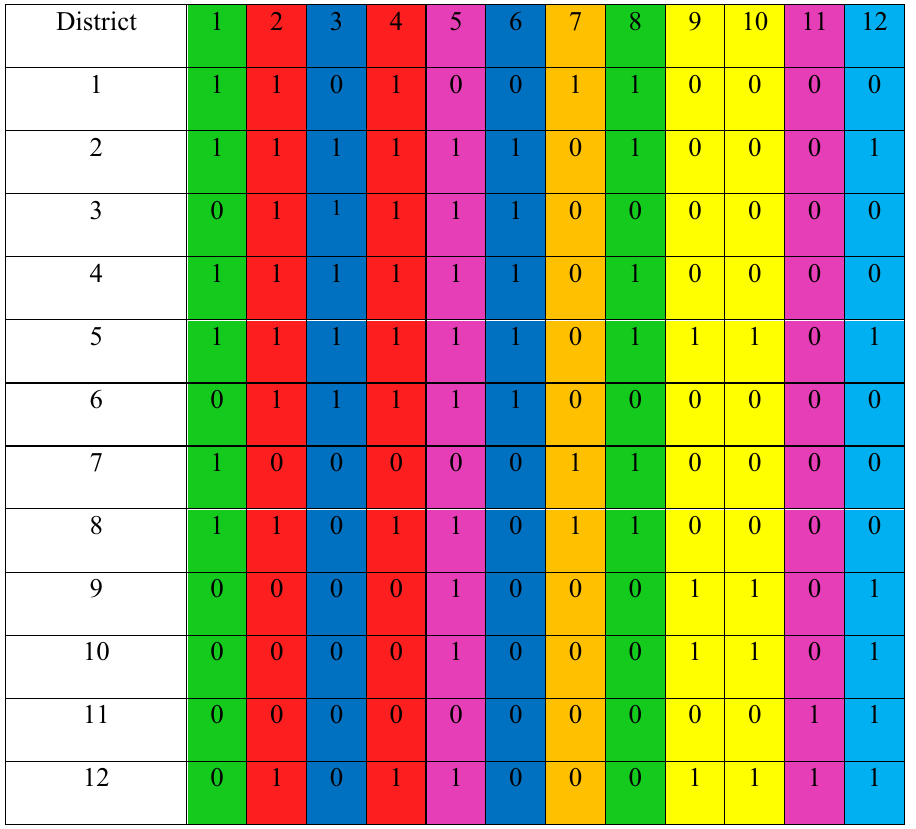
Table 8. Equivalence matrix and clustering of Karaj City districts in terms of FR for α -Cut = 0.9.